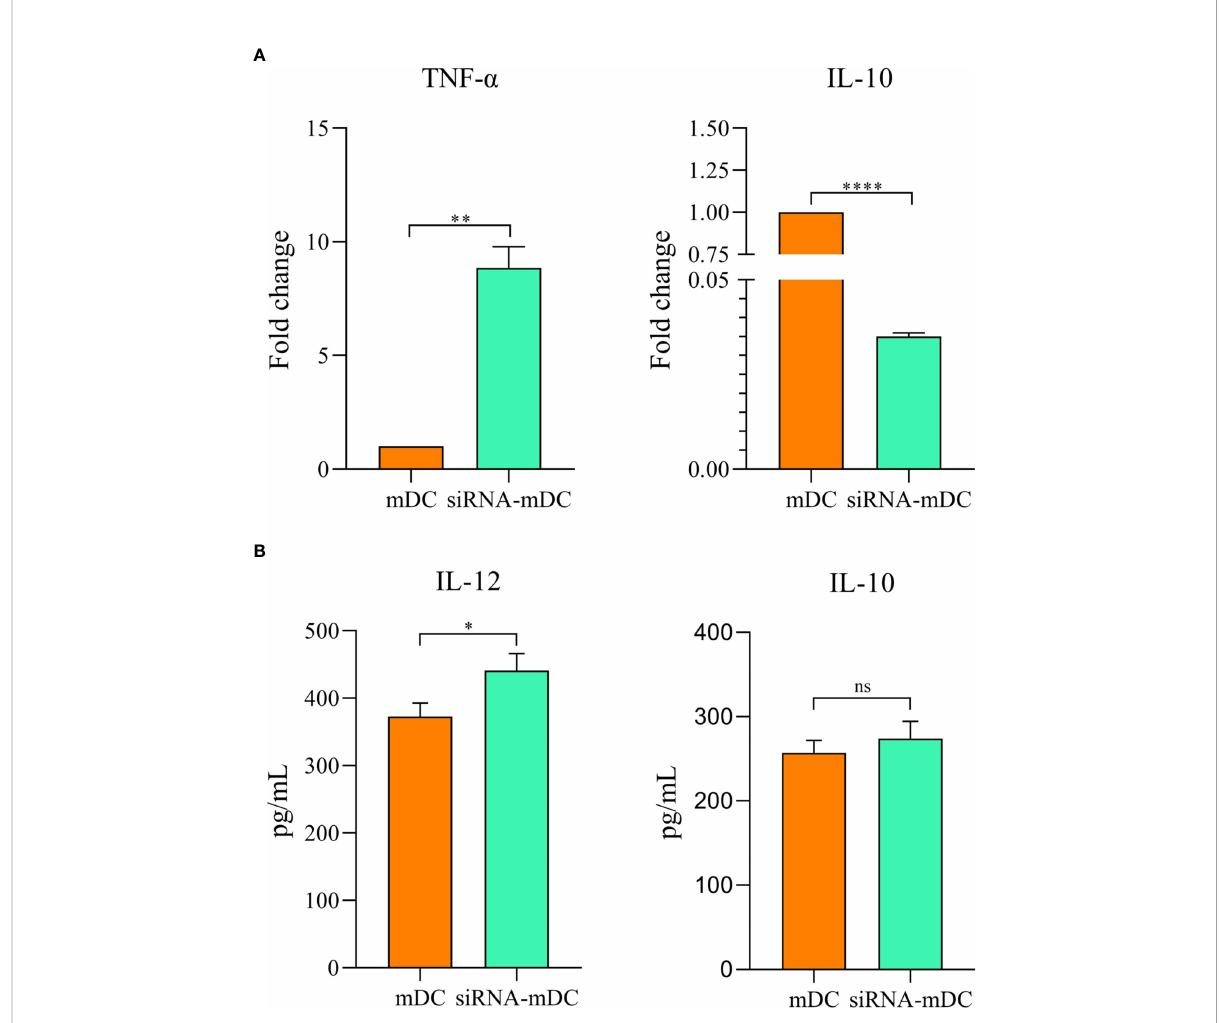
FIGURE 3 Cytokine expression and secretion pro fi le in mDCs and CTLA-4-silenced-mDCs. The expression levels of TNF- a and IL-10 (A) were assessed by qRT-PCR. IL-12 and IL-10 (B) quantities in the cell culture supernatants was evaluated by ELISA; (ns, not signi fi cant, *P ≤ 0.05, **P ≤ 0.01, and ****P ≤ 0.001). CTLA-4, Cytotoxic T-lymphocyte-associated protein-4; mDCs, Tumor cell lysate-loaded mature dendritic cells; siRNA-mDCs, CTLA-4-silenced mDCs; qRT-PCR, Quantitative Real-time polymerase chain reaction; ELISA, Enzyme-linked immunosorbent